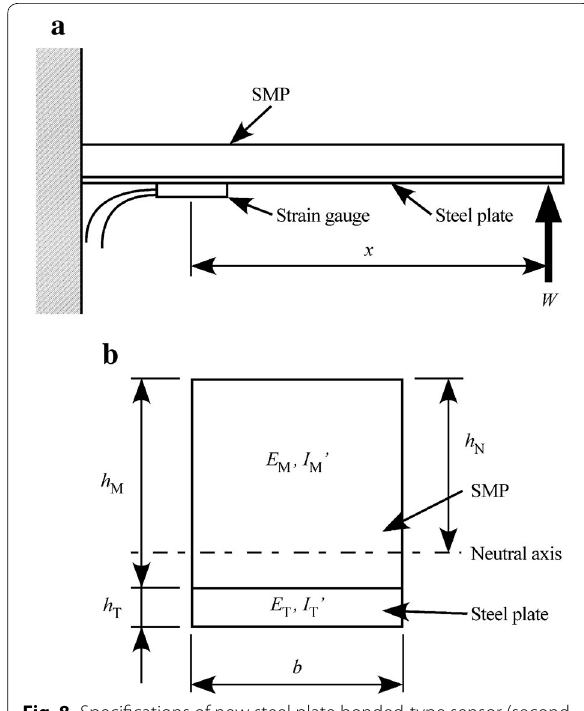
Fig. 8 Specifications of new steel plate bonded-type sensor (second prototype). a Overview. b Cross